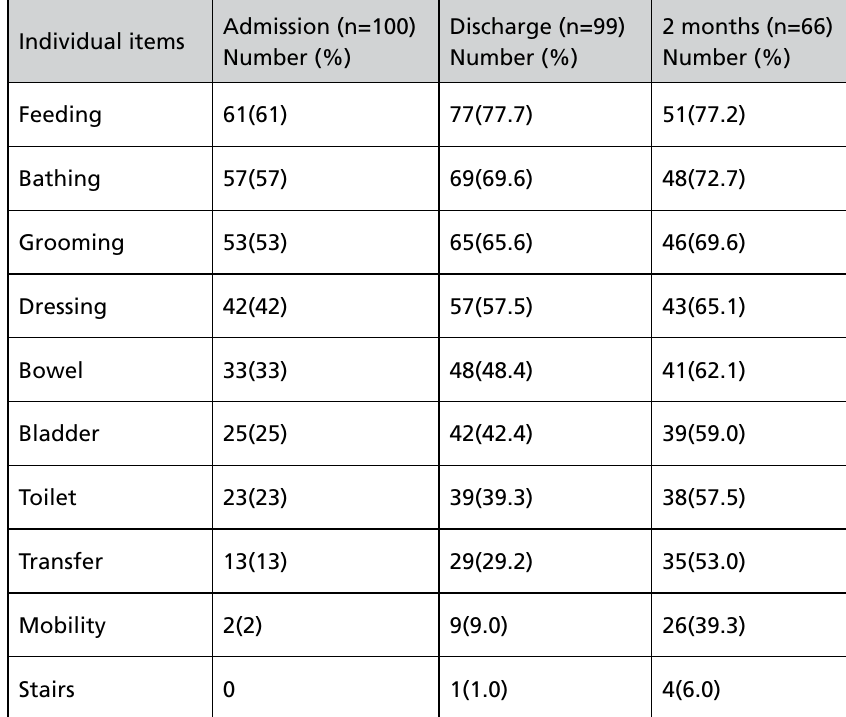
table 1: Descriptive statistics of